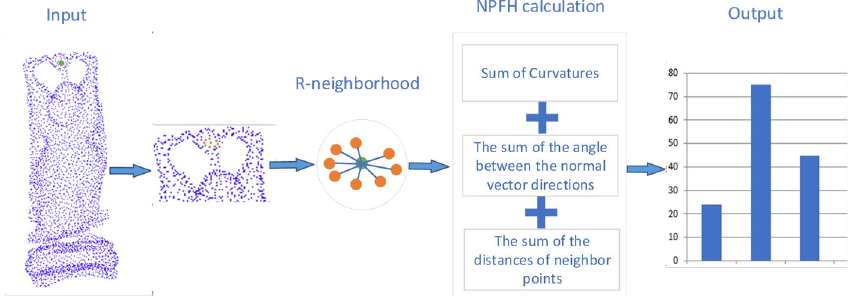
Figure 4. Schematic representation of NPFH characterization mechanism.